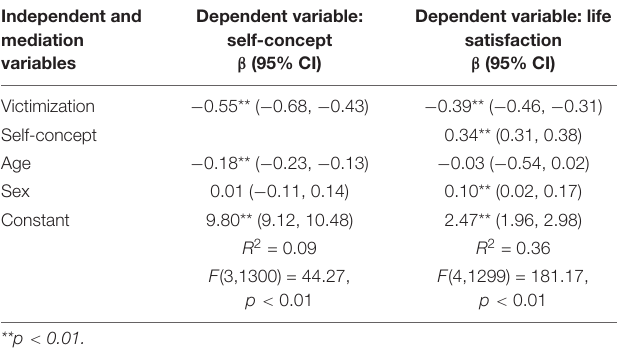
TABLE 2 | Coefficients for the tested mediation model between victimization and life satisfaction.